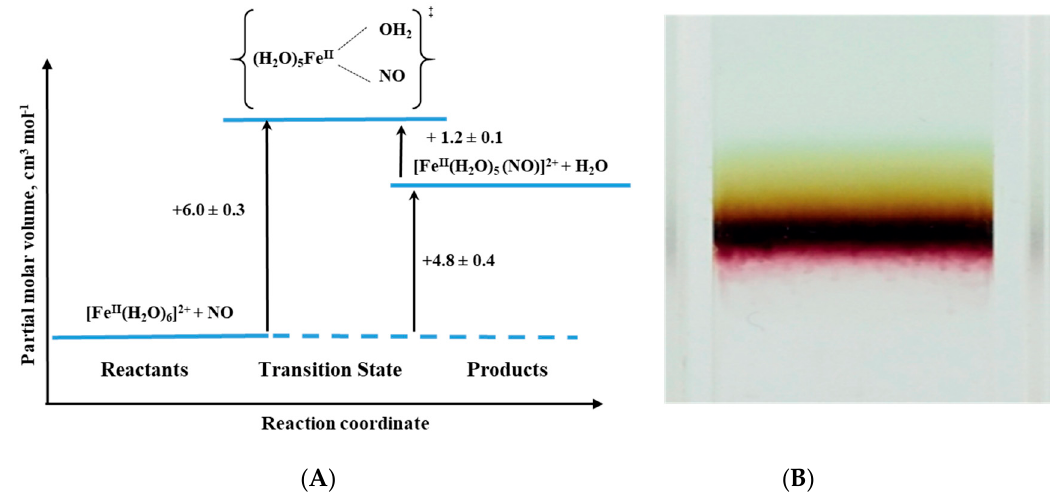
Figure 15. ( A ) Volume profile for the reaction of [Fe(H 2 O) 6 ] 2+ with NO. ( B ) A picture of the brown-ring formed during the test for nitrate or nitrite [45]. Copyright Wiley-VCH GmbH. Reproduced with permission.